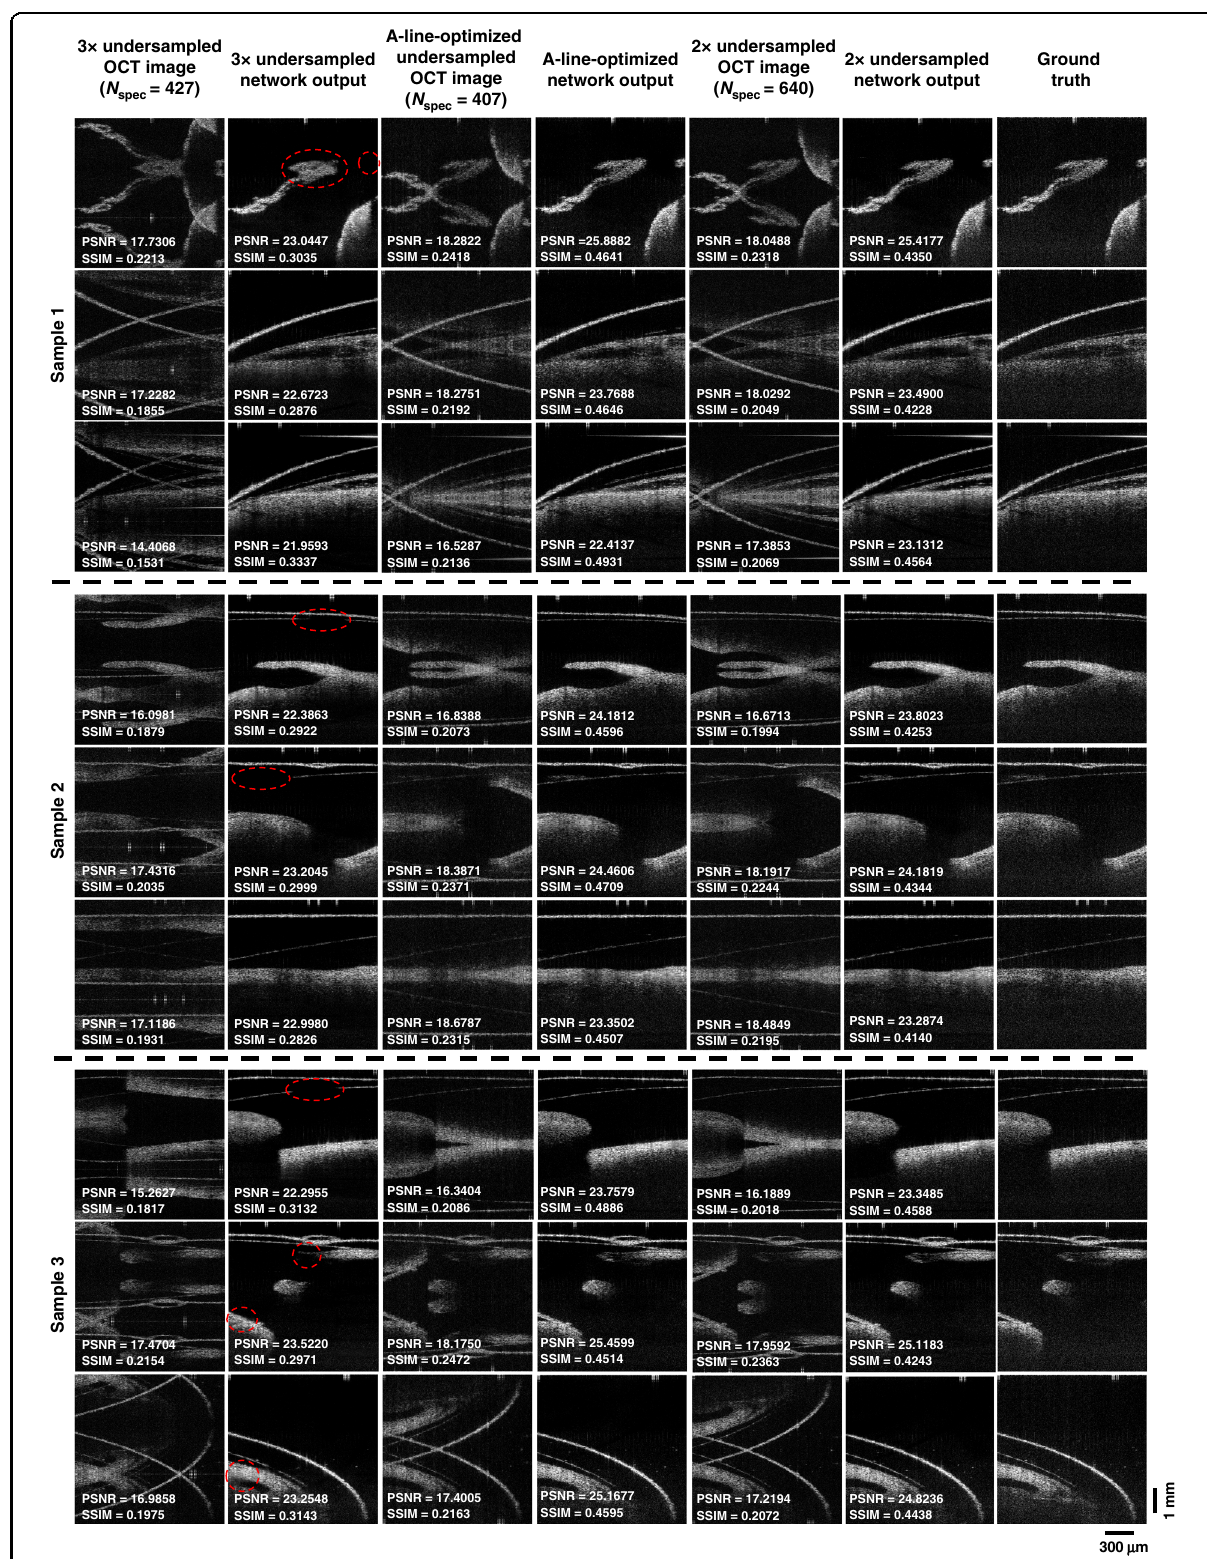
PSNR = 16.1889 SSIM =